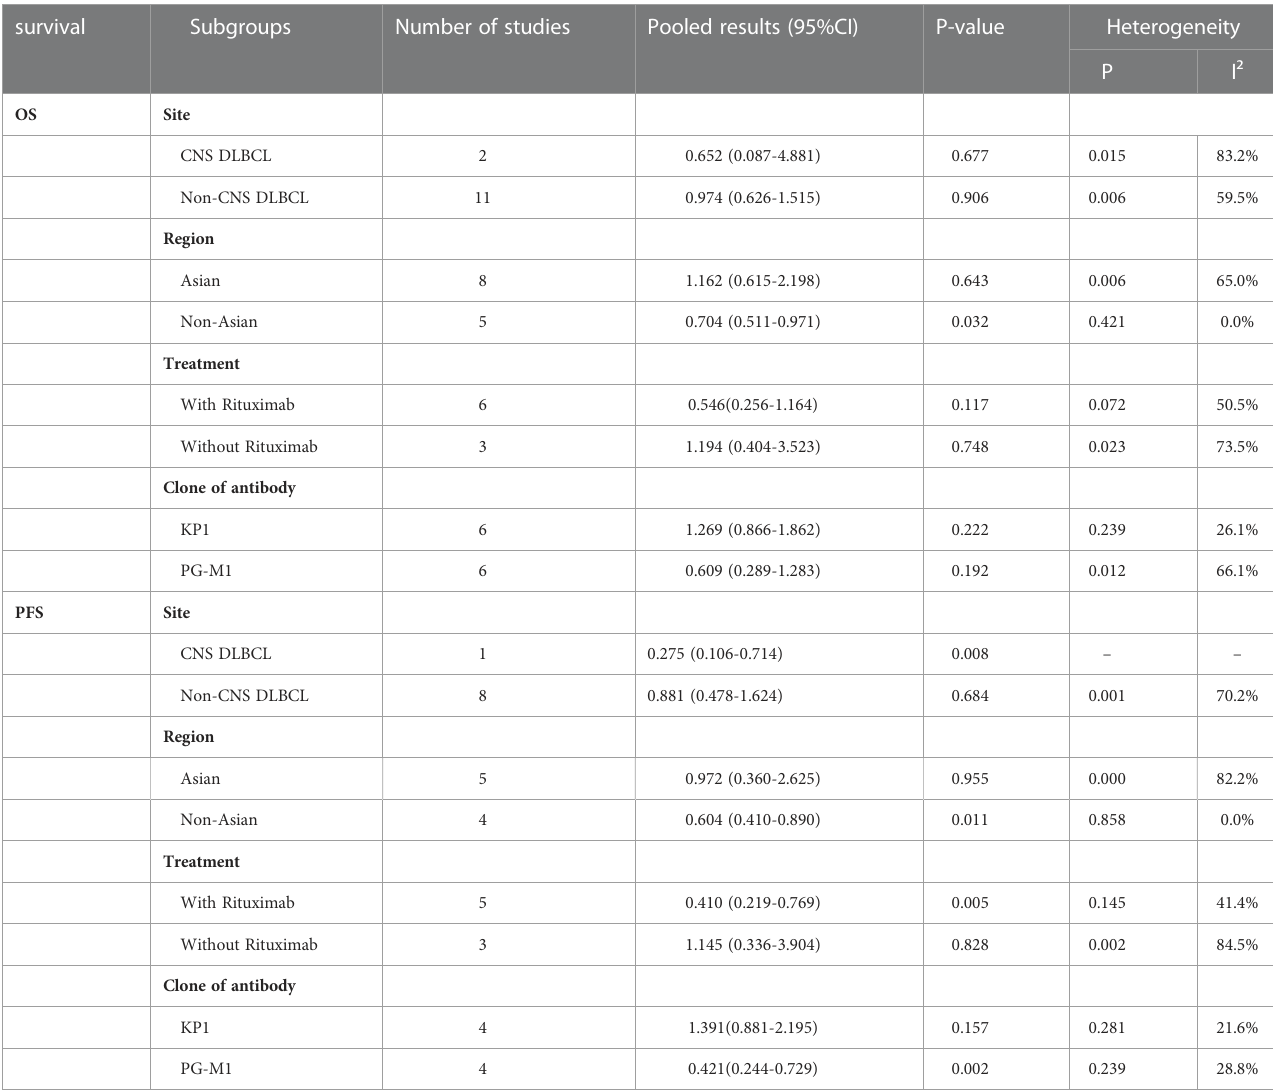
TABLE 2 Subgroup analysis of total TAMs and survival.